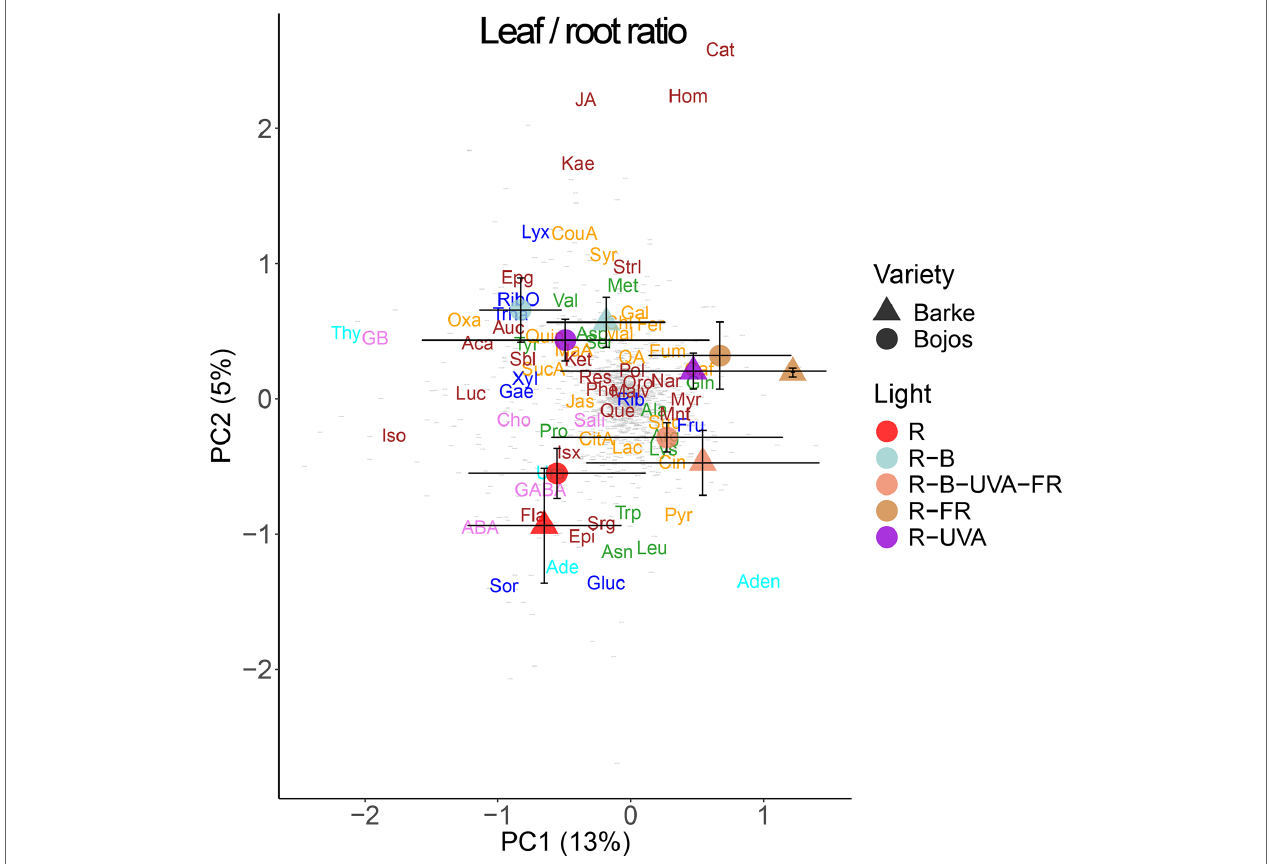
FIGURE 9 | Principal component analysis (PC1 vs. PC2) of root-to-leaf ratios of metabolite concentrations of two barley varieties grown for 26 days under different light regimens. Additional details are in the Figure 6